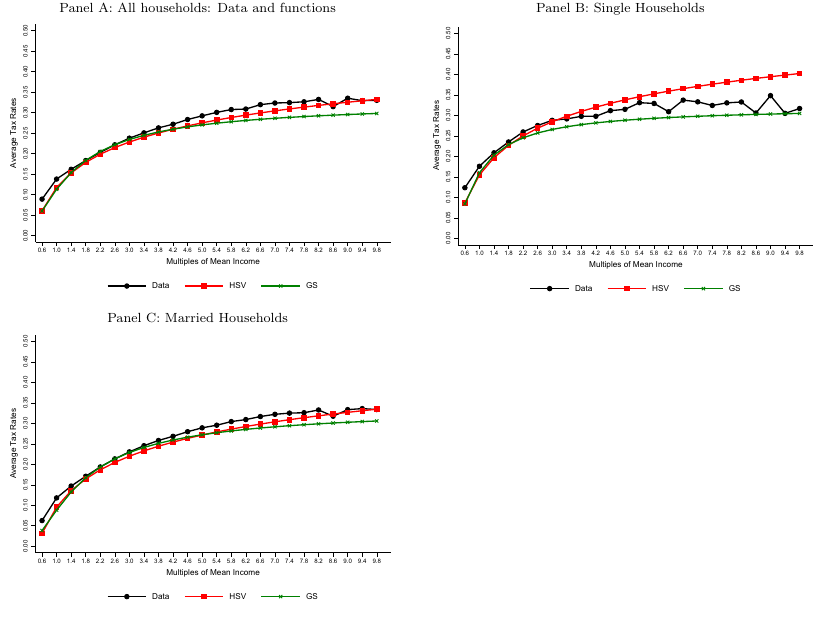
Fig. 8 Effective average tax rates: data and functions (households